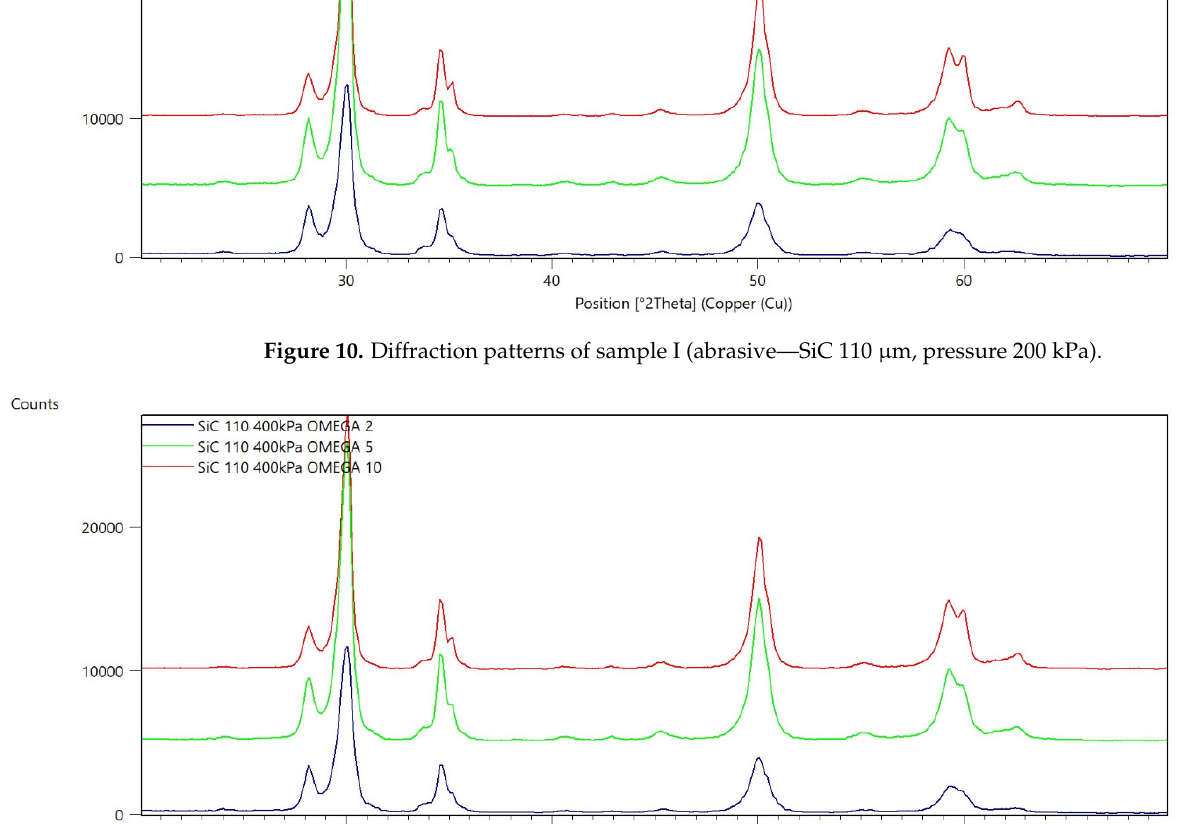
Figure 11. Diffraction patterns of sample J (abrasive—SiC 110 μ m, pressure 400 kPa).